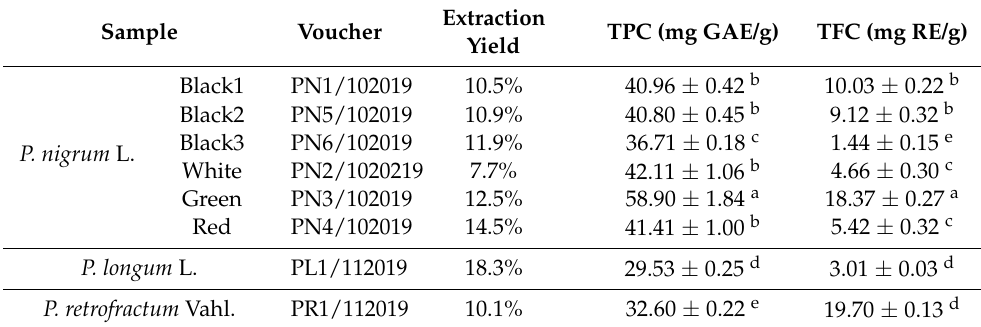
Table 1. Extraction yields, total phenolic and flavonoid contents in the methanolic fruit extracts obtained from different spices of genus Piper . Sample